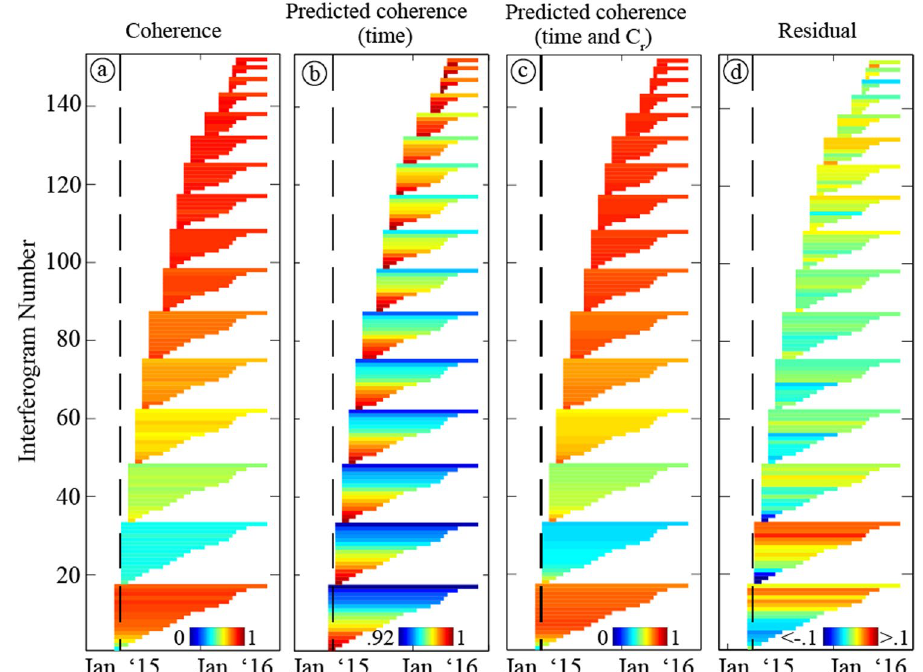
Figure 3. Full coherence dataset at an alluvial fan site (Track 156). ( a ) Interferometric coherence between all available acquisitions for Track 156 (Supplementary Table 1, Supplementary Figure 2), sorted by master, then secondary date, and colored by coherence at alluvial fan point (A) indicated in Fig. 1b. Vertical black line indicates timing of March 2015 rain event. ( b ) Expected coherence due to timespan alone, based only on SAR data acquired after October 1, 2015. ( c ) Coherence predicted from timespan and proxy for soil moisture. ( d ) Residual between ( a ) and ( c ). Note smaller color scale in b and d